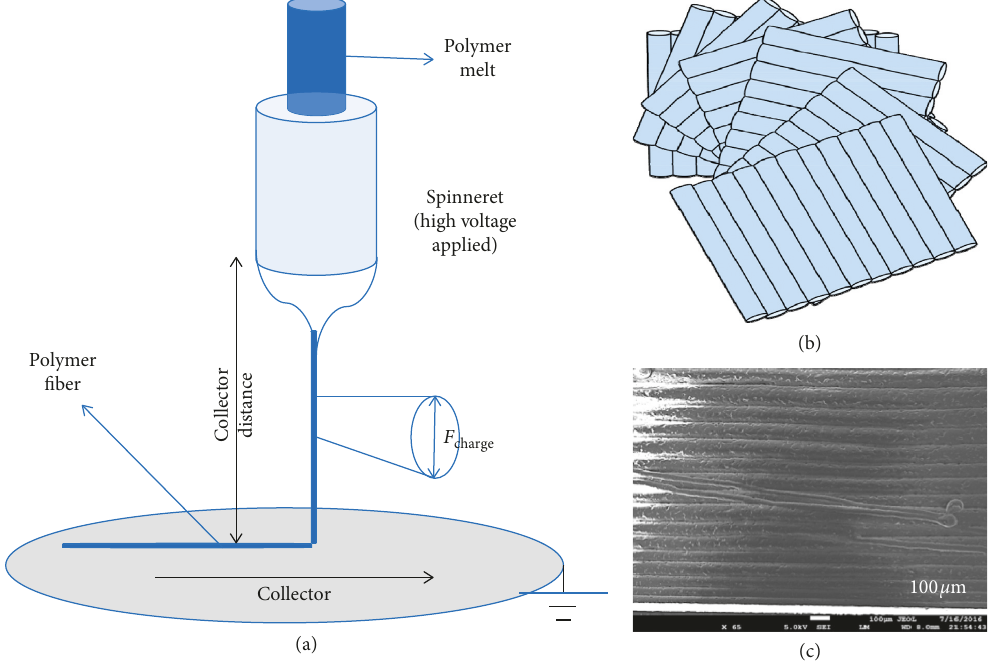
Figure 1: Methodology, design, and SEM images of one layer of 3D Helicoidal Structure. (a) Schematics of near-field melt electrospinning (NFES)—the process used to first lay down patterns of electrospun fibres on top a collector; (b) illustration of a top view of the hierarchical helicoidal design of the basic building blocks found in shells of mantis shrimp dactyl club, as reported in the literature; (c) scanning electron microscope (SEM) image of a layer of highly aligned, dense fibre-structured samples of melt electrospinning fibres with diameters around 10 µ m at 65x